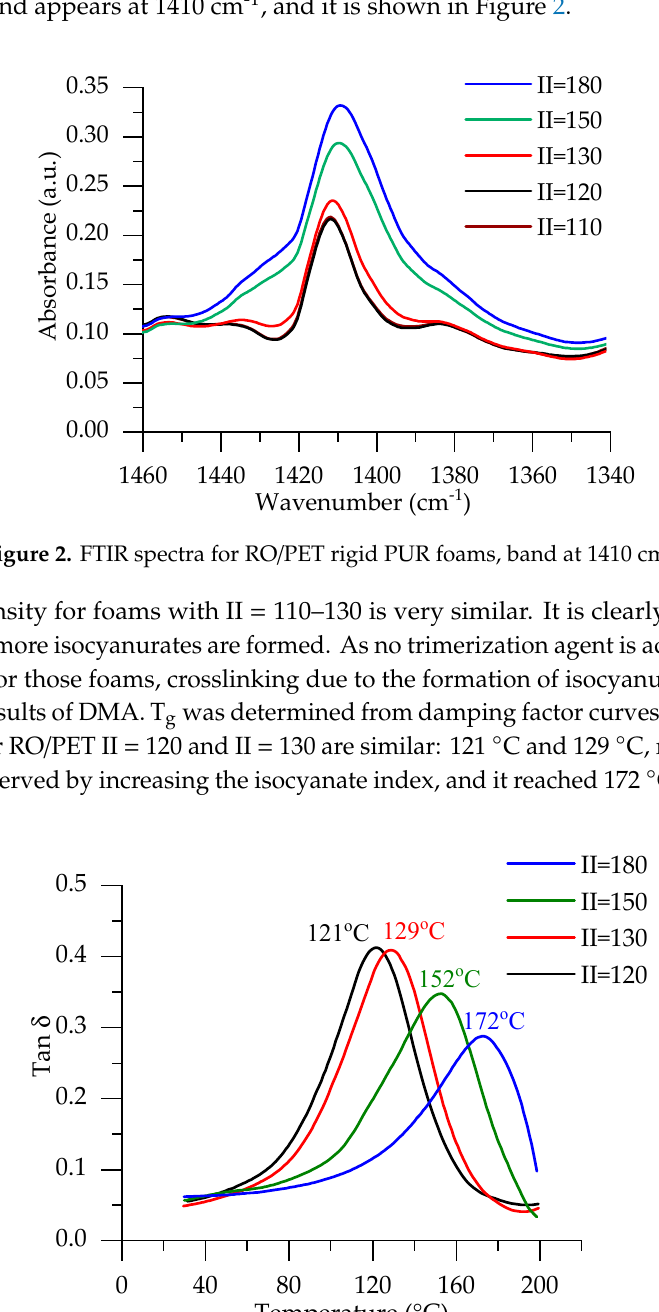
Figure 3. Damping factor curves of RO/PET series rigid PUR foams.